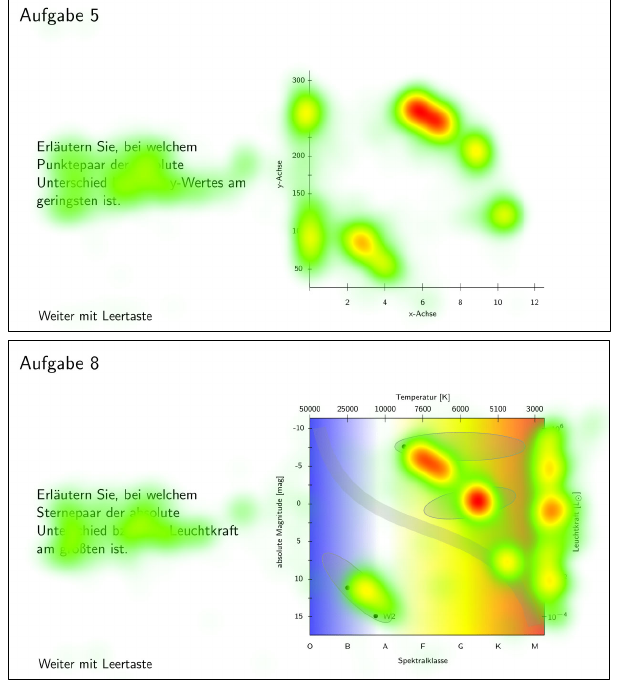
solving).FIG. 9. Heat maps of an isomorphic pair of items (T 8 † ) as originally used in the study (English translations can be found in the Supplemental Material [51]). These heat maps are for all participants. Information must be taken from the left y axis (top) and from the right luminosity axis (bottom). In both cases, the relevant values of the points or stars must be extracted and compared. Note the more extensive consideration of the loga- rithmic luminosity axis (bottom) compared to the linear y axis